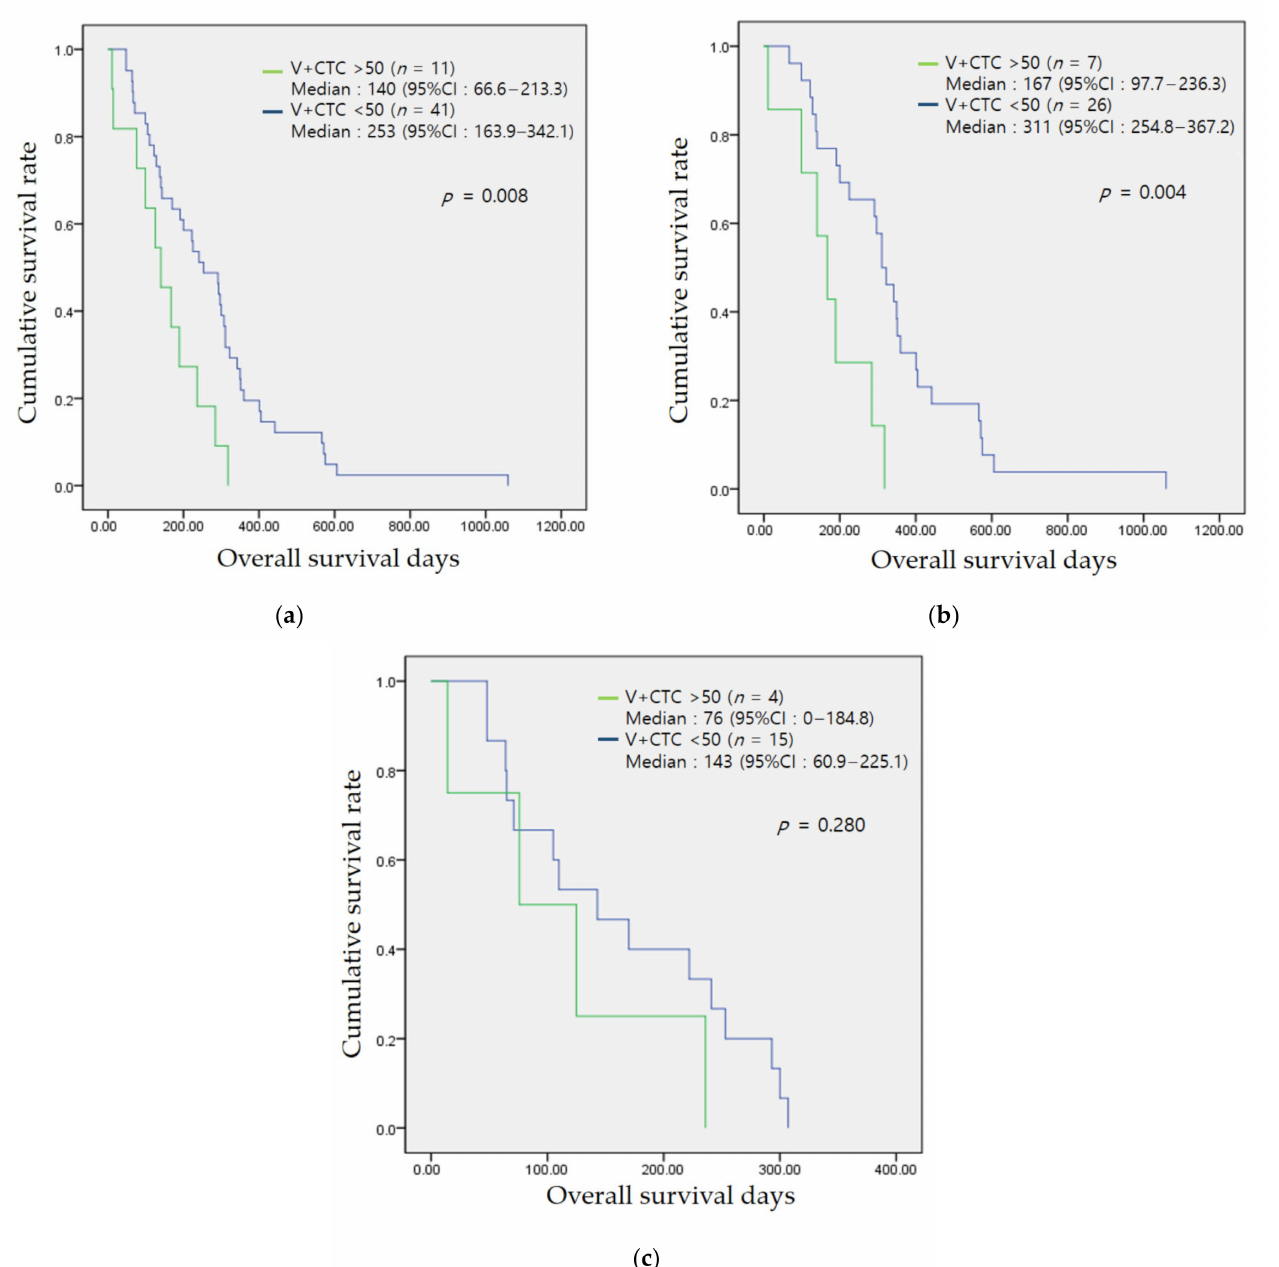
Figure 4. Kaplan–Meier overall survival in total ( a ), resectable ( b ) and unresectable ( c ) biliary tract cancer